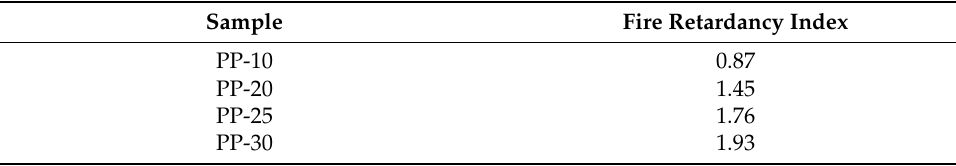
Figure 7. Digital photos of PP-0 and PP-30 after cone calorimeter measurements. Table 4. Flame retardancy index of PP/TiO 2 /lignin composites.